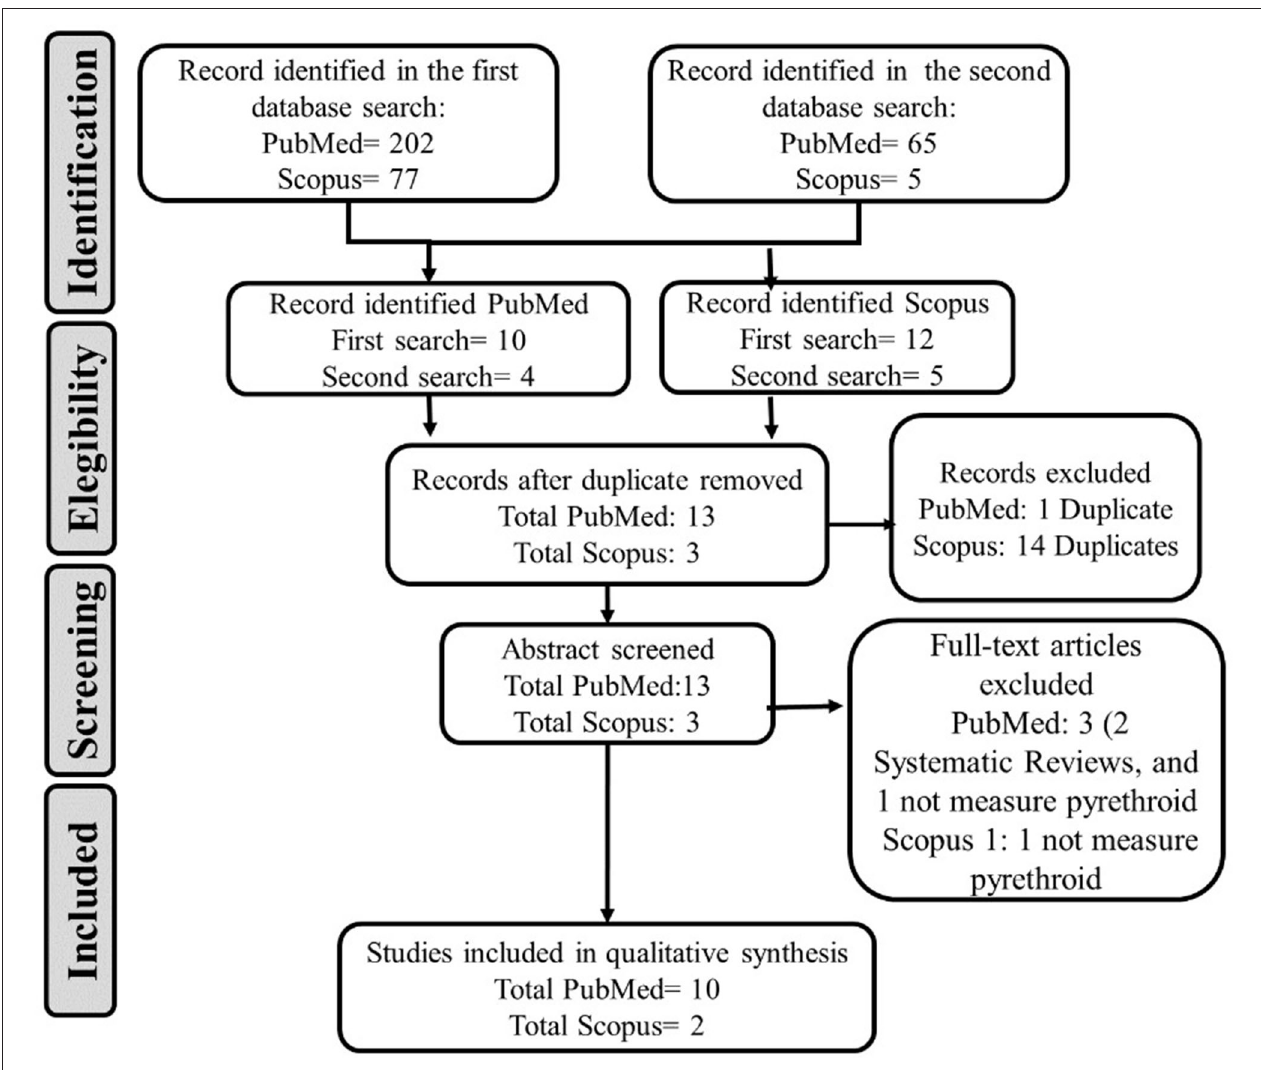
FIGURE 1 | PRISMA flow diagram adapted from the systematic bibliographic review process carried out and its